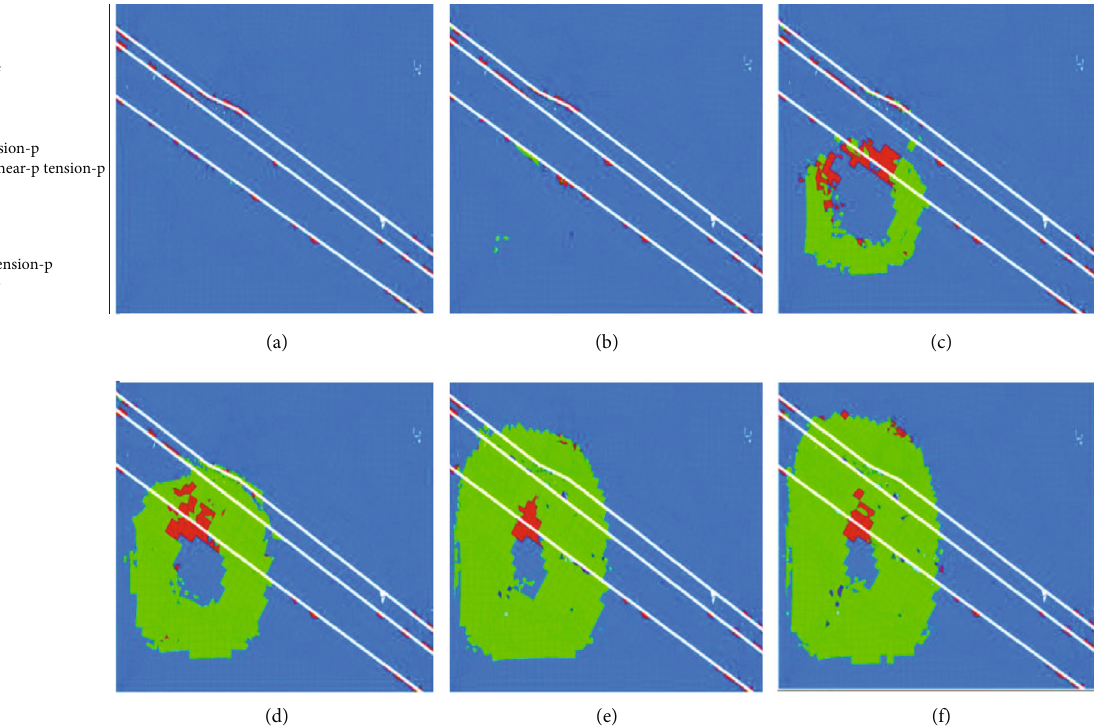
Figure 11: Plastic zone of side of 3 coal roadway during advancing of 97308 working face. (a) Working face advancing 120m; (b) working face advancing 160 m; (c) working face advancing 200m; (d) working face advancing 240m; (e) working face advancing 280 m; (f) working face advance over